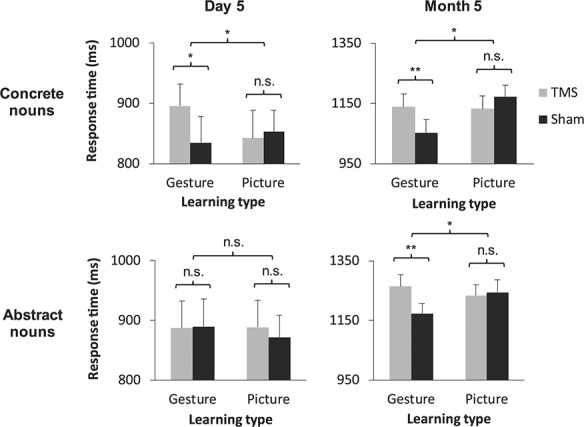
Effects of bmSTS stimulation on speed of L2 translation by time point and vocabulary type. L2 vocabulary translation response times in the multiple-choice task at the day 5 TMS session (left) and month 5 TMS session (right) by stimulation type, learning type, and vocabulary type (n = 22 participants). Compared with sham stimulation, stimulation of the bmSTS delayed response selection for concrete gesture-enriched nouns at day 5 and for both concrete and abstract gesture-enriched nouns at month 5. Error bars represent one standard error of the mean. *P < 0.05, **P < 0.01.